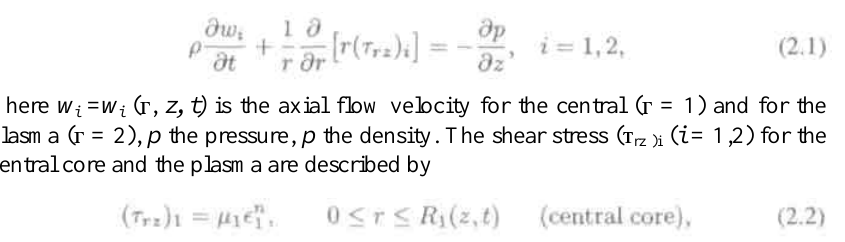
Figure 1. Geometry of the arterial stenosis with peripheral layer Since the elastic arteries have high wave velocity (typically 5000-10000 m/sec.) due to the pulsatile nature of the streaming blood as evident from [3], this results in long wave lengths (about 10 times the length of the aorta at the fundamental cardiac frequency), small axial and radial convective acceleration and very small axial diffusion of momentum at axial distances far from the entrance of the arterial tube [22]. Keeping in view of these simplifying assumptions and considering the stenotic blood flow to be axisymmetric, laminar, one-dimensional and fully developed, the basic equation of motion governing the unsteady flow in the absence of any radial and rotational flow may be written